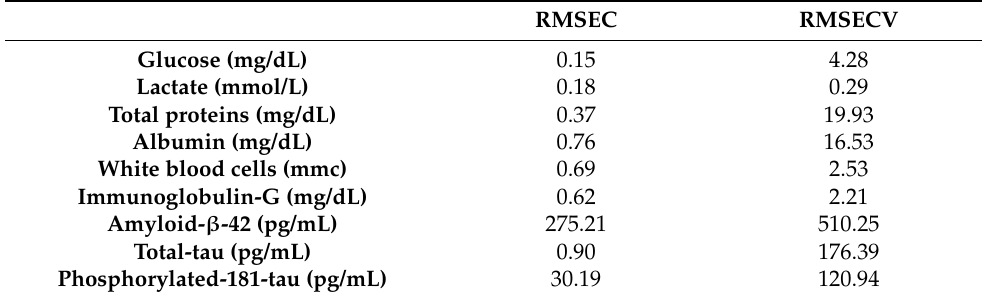
Table 6. Partial least squares regression: root mean square error in calibration (RMSEC) and root mean square error in cross-validation (RMSECV) of CSF biochemical